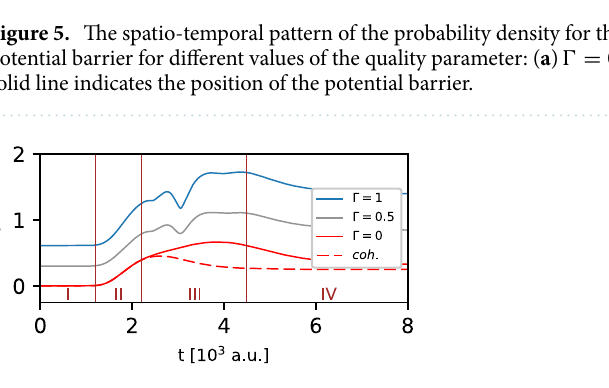
Figure 6. Influence of the quality parameter Ŵ on the non-classicality parameter for the DSC-state with the relative phase ϑ = 0 , which interacts with the Gaussian barrier. The dashed line corresponds to a single Gaussian